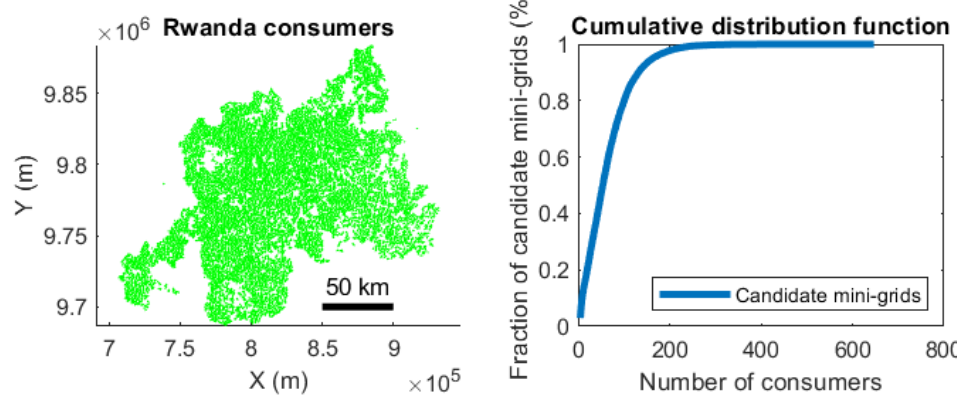
Figure 5. Rwanda unelectrified consumers and candidate mini-grid sizes.